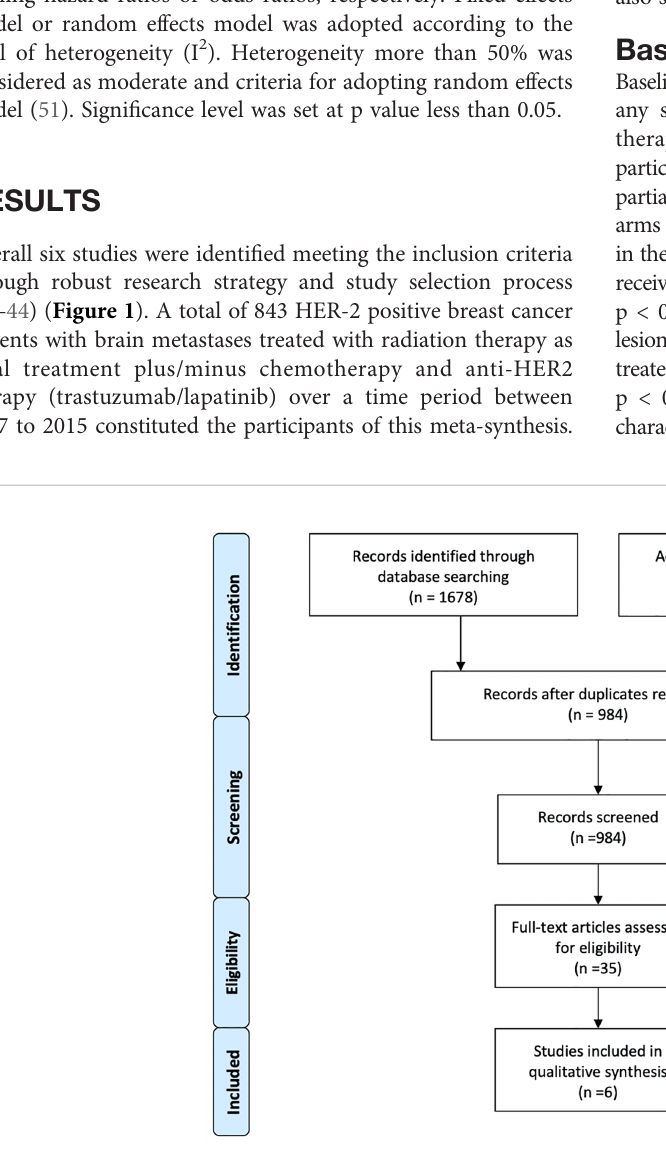
FIGURE 1 | PRISMA fl ow diagram of search strategy and study